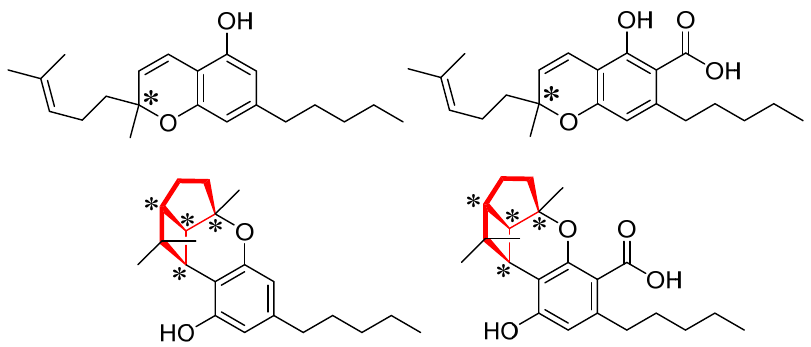
Figure 1. Cannabichromene ( top left ), cannabichromenic acid ( top right ), cannabicyclol ( bottom left ), cannabicyclolic acid ( bottom right ). The starred (*) carbons indicate chiral centers. The red bonds highlight the fused ‐ ring system which results in the chirality of CBL and CBLA.